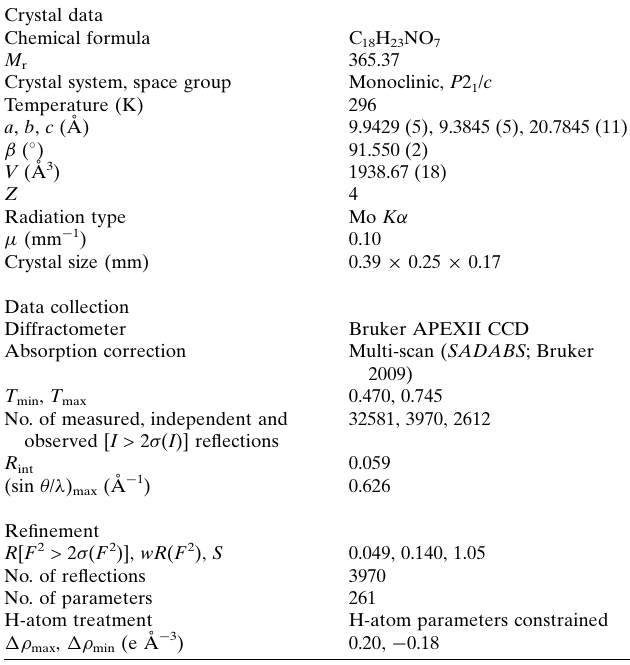
Table 2 Experimental